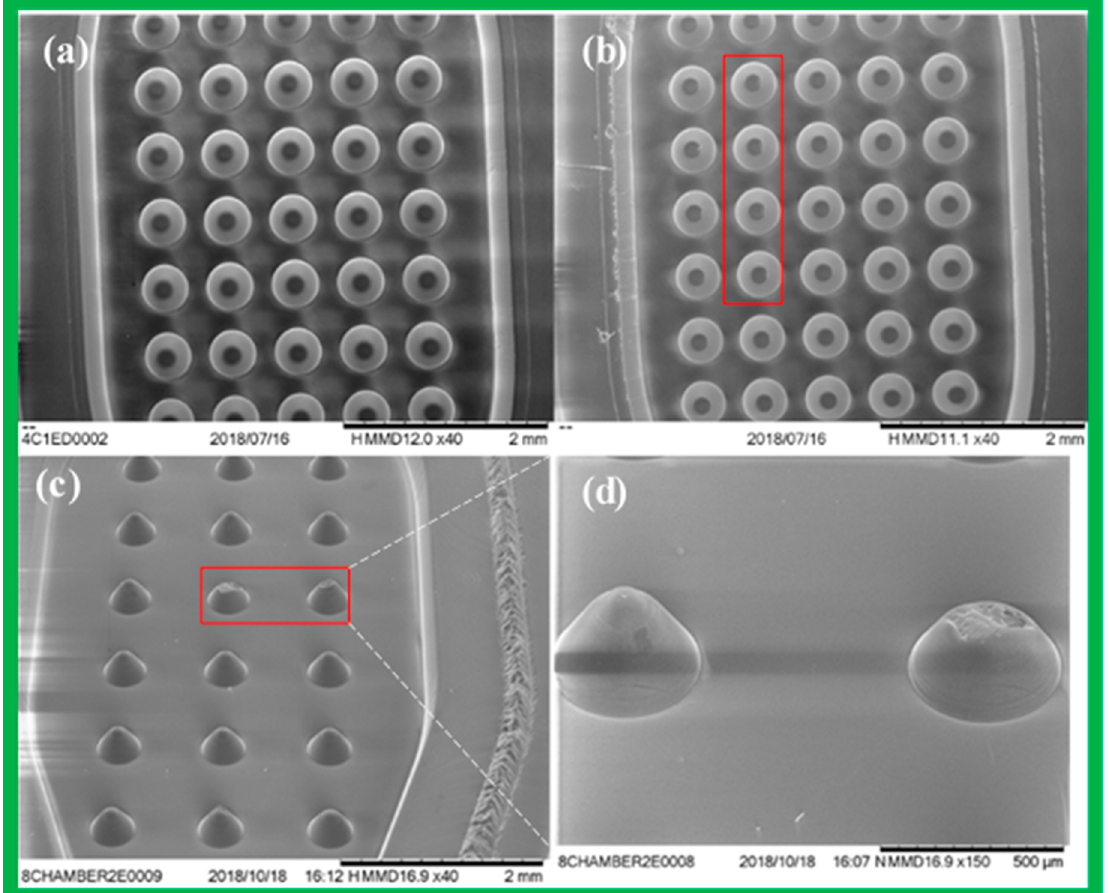
Figure 5. SEM images of: ( a ) Good 3D microstructures fabricated by polymer injection moulding using a milling shim, with enough washing time. ( b ) Defected structures caused by insufficient washing time (less than 30 min). ( c ) Defected structures when the shim did not have a washing step. ( d ) The enlargement of two defected microstructures shown in (c).